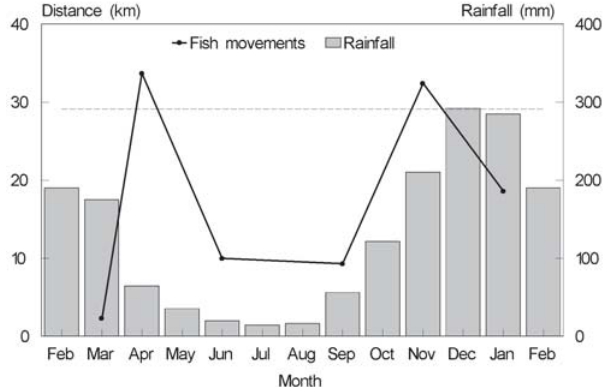
Fig. 2. Movements of jaú in Funil Reservoir, rio Grande, and rainfall in rio das Mortes. The y-axis on the left shows dis- tances to Funil Dam. The horizontal dashed line indicates the location of the rio das Mortes mouth before it was flooded.